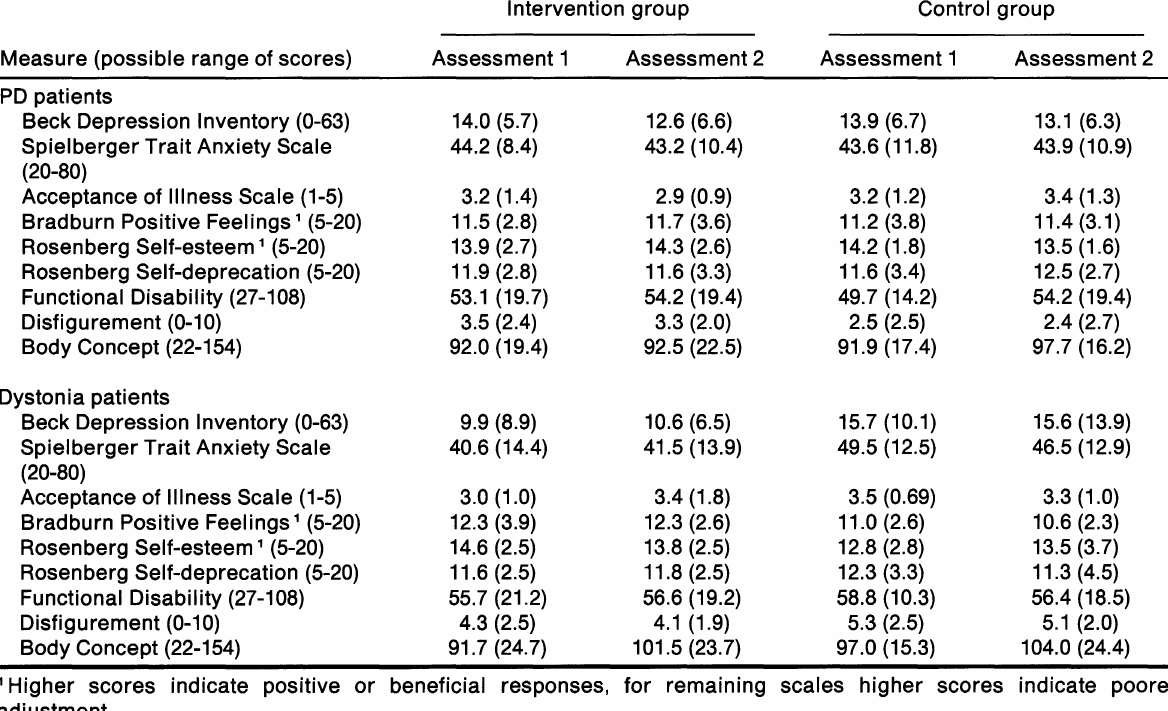
TABLE II. Mean scores (and S.D.) of the PD and dystonia patients allocated to the "intervention" and "control" groups at the first and second